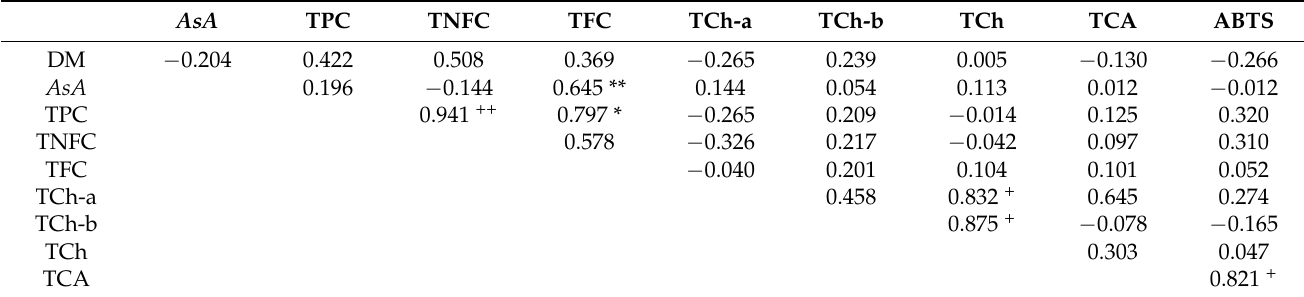
Table 3. Correlation matrix between the observed parameters.